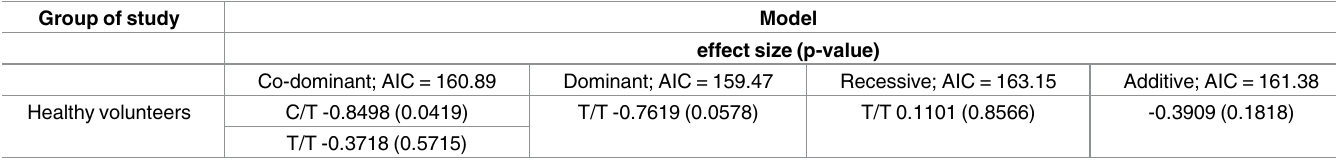
Table 6. Association analysis of the CD14(-159C/T) polymorphism with DTH to PPD (adjusted by BCG doses) in healthy, young volunteers using logistic regression. Group of